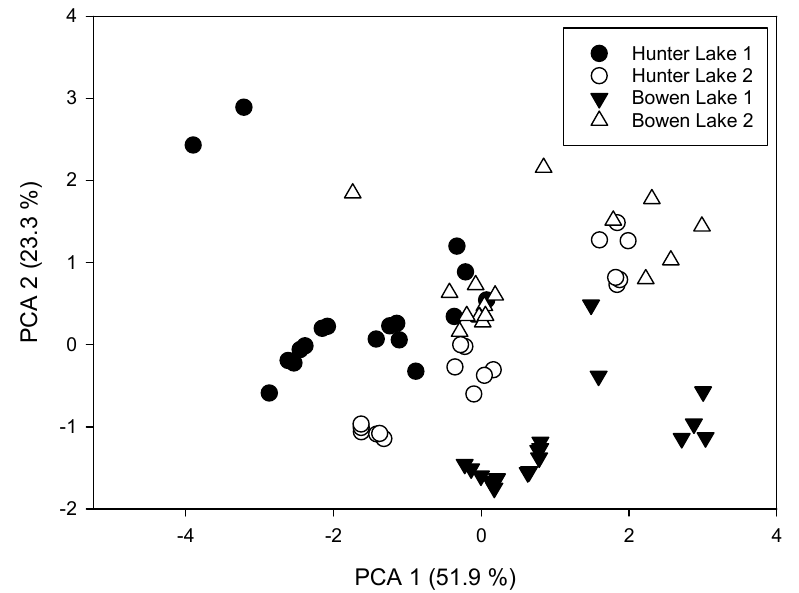
Figure 7. Principal components analysis (PCA) ordination of in situ water quality measurements from pit lakes in the Bowen Basin, Queensland and the Hunter Basin, New South Wales, Aus- tralia. Data shows an overlay of “lake” as indicated in figure legend.